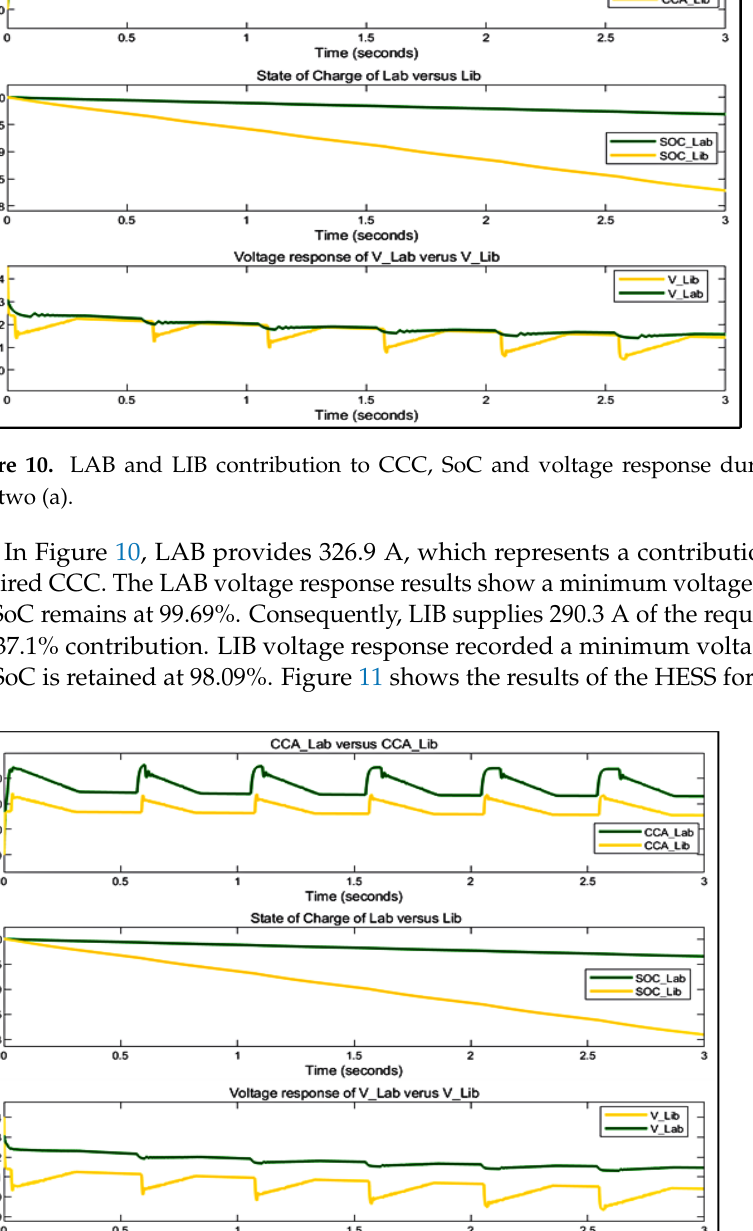
Figure 11. LAB and LIB contribution to CCC, SoC and voltage response during discharge for case two (b).